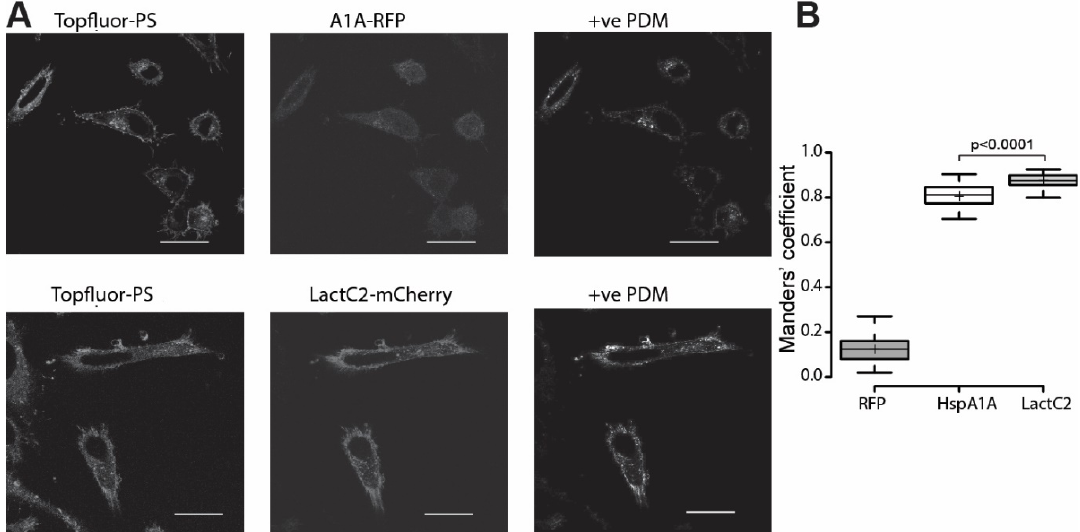
Figure 4. HspA1A co-localizes with TopFluor-PS in human cells. (A) Representative images of HeLa cells showing the co-localization of HspA1A (top panel) and Lact-C2 (lower panel) with PS at 37°C. (B) Quantification of the co-localization using the Manders’ co-localization coefficient analyses using 20, 26, and 25 cells from three independent experiments. Center lines show the medians; box limits indicate the 25th and 75th percentiles as determined by R software; whiskers extend 1.5 times the interquartile range from the 25th and 75th percentiles; crosses represent sample means. The images showing the +ve PDM (see materials and methods) values were included to show co-localization. Scale bar = 10 μm. The P values of the student t -test were: RFP/HspA1A <0.0001; RFP/ LactC2 <0.0001; HspA1A/LactC2 <0.0001.